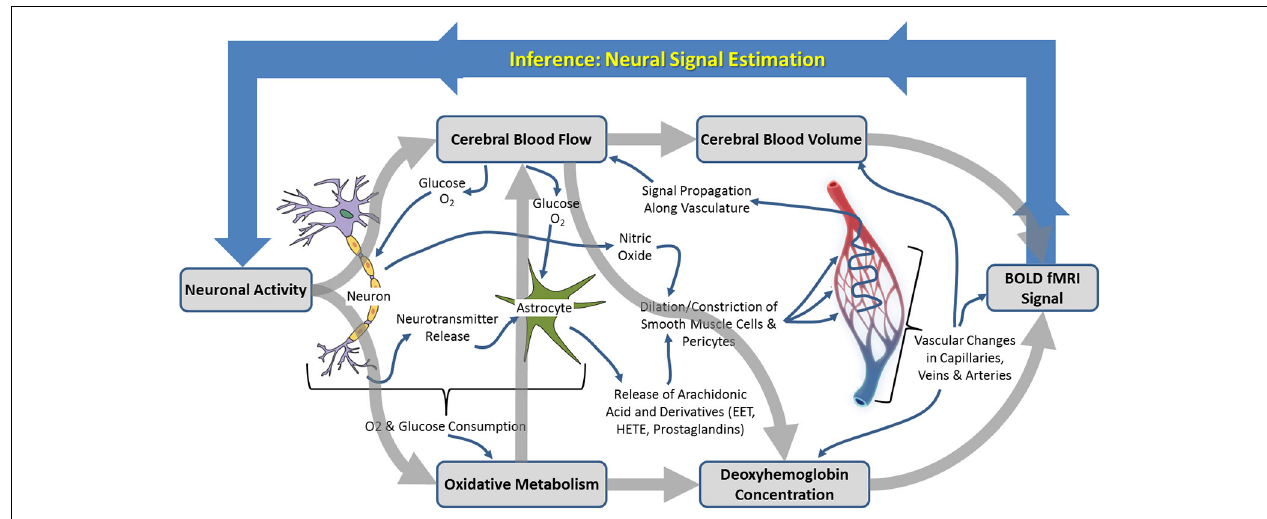
FIGURE 1 | Schematic illustration of the neurophysiological processes underpinning hemodynamic neuroimaging signals. The boxed processes linked by thick gray arrows around the outside represent components of interest to those focussing on “parametric neurovascular coupling,” whereas the more detailed processes illustrated in the center